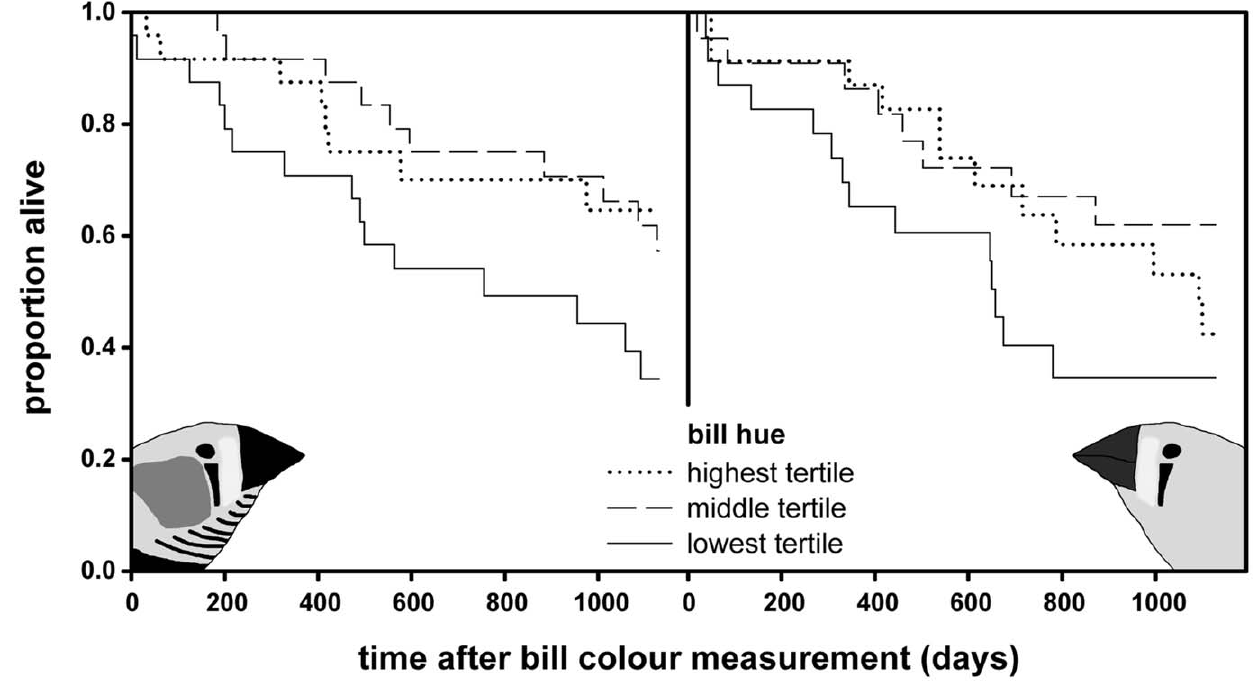
Figure 1. Bill hue and survival. Survival of males (left panel) and females (right panel) in relation to bill hue categories (tertiles). Note that data are shown for bill hue tertiles but bill hue was entered as continuous variable in the analyses. In both sexes individuals with low redness survive worst. In females a quadratic relationship of survival with bill hue was detected (see main text).